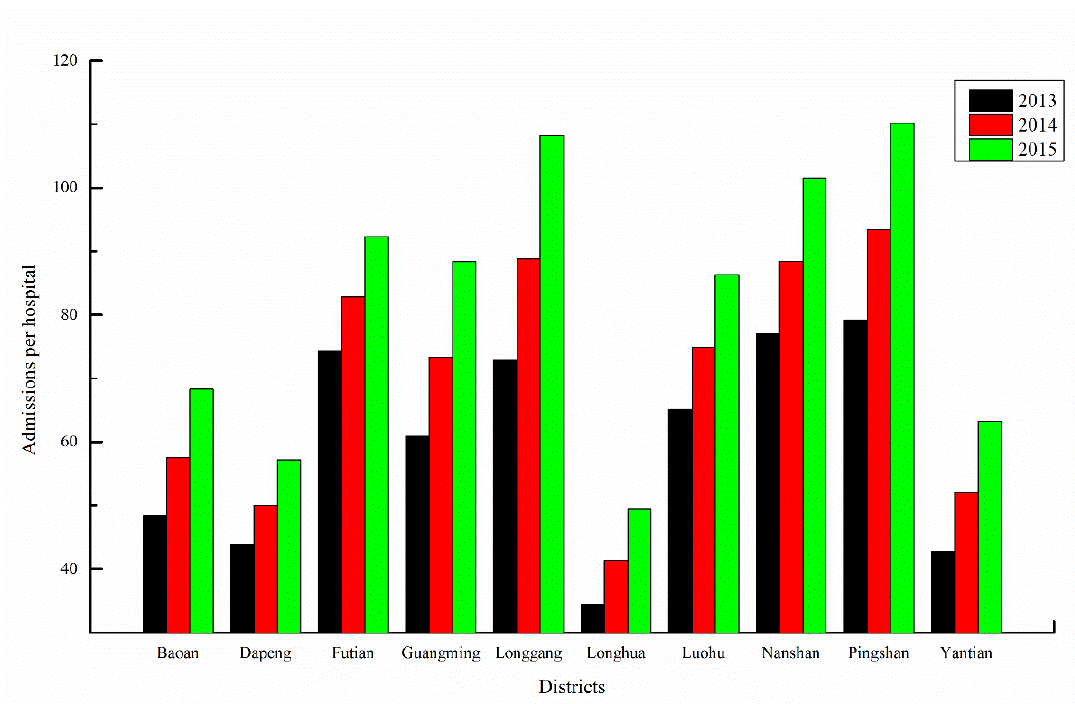
Figure 11. Mean admissions per hospital for each district in